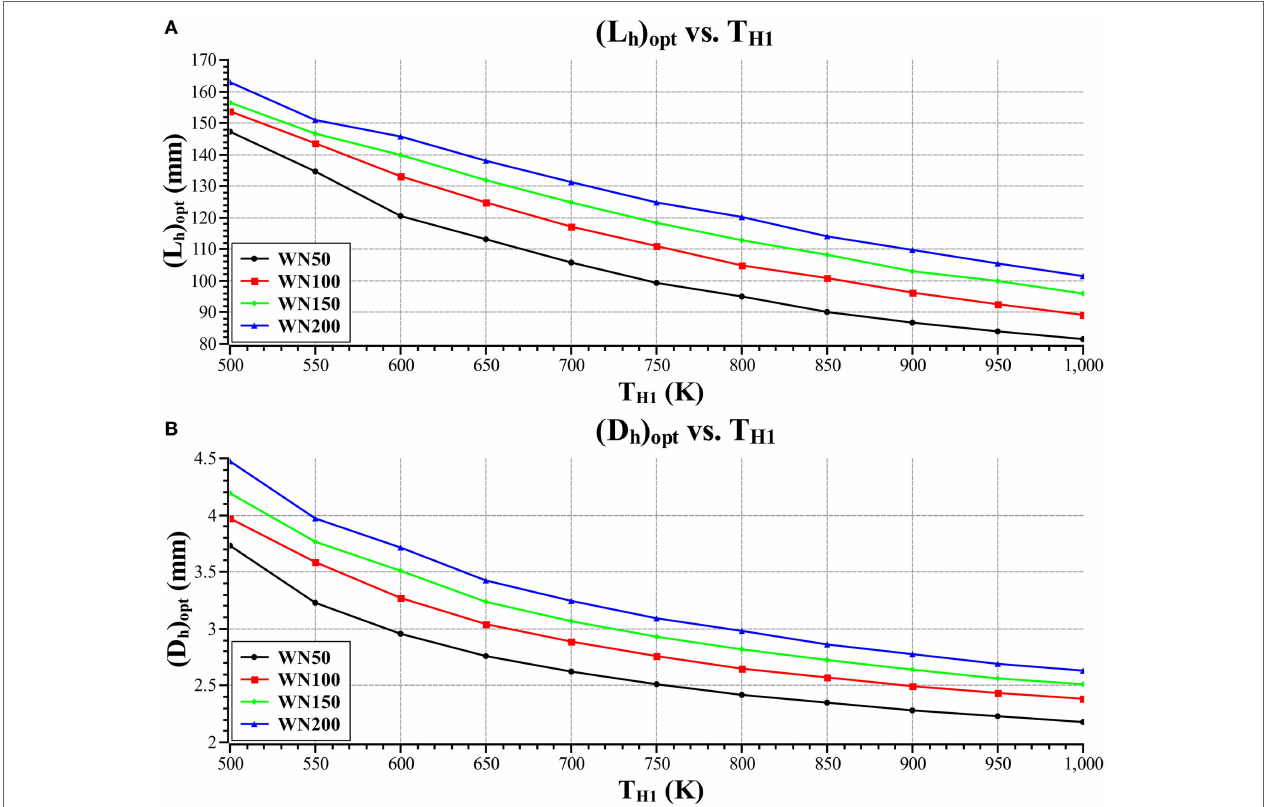
FIGURE 10 | Optimal heater tube length (A) and diameter (B) versus heater inlet